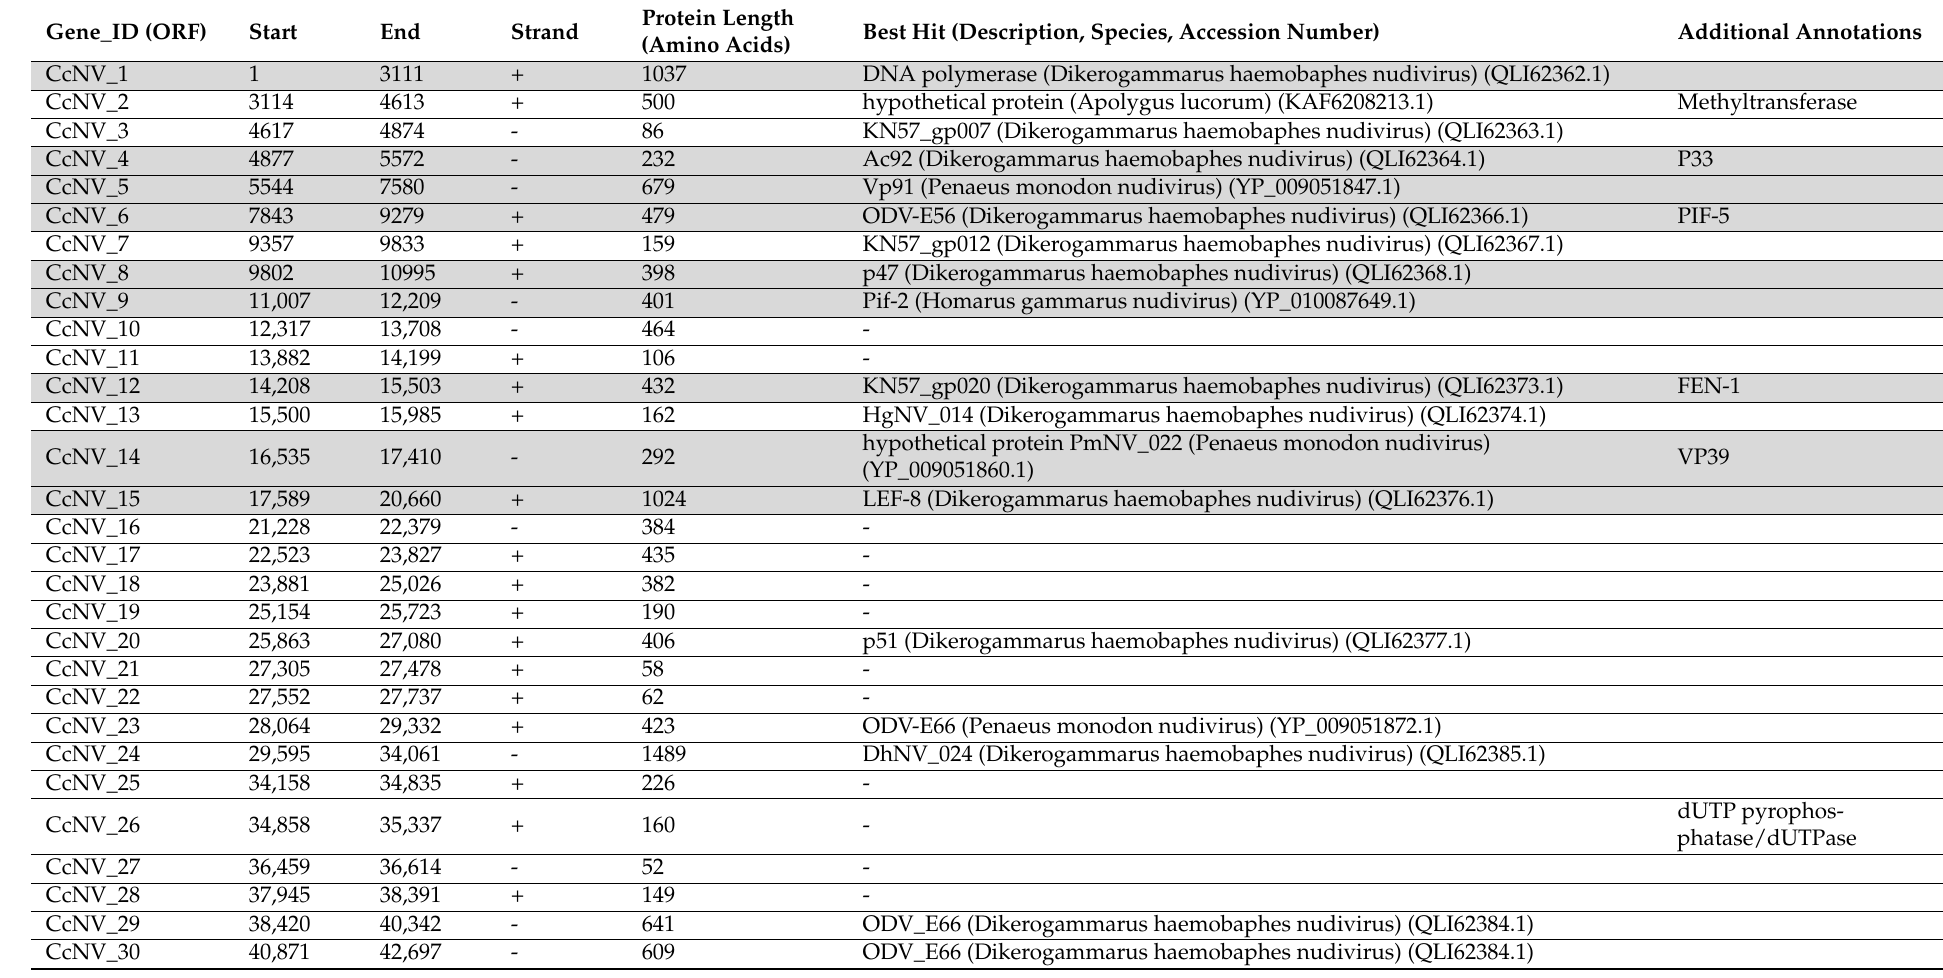
Table 1. Identified open reading frames (ORFs) in the CcNV genome. The start and end positions of the ORFs are shown, as well as the strand it was found on, the deduced protein length (in amino acids), the best hits obtained using blastp similarity searches using the NCBI nr protein database (E-value < 0.001), and additional information obtained from annotated orthogroups (Table S5). Nudivirus core genes are highlighted in